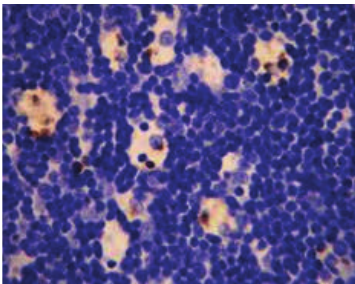
Figure 11: Model control group—28 d in OJ experiment thymus (many apoptoic cells), TUNEL ×